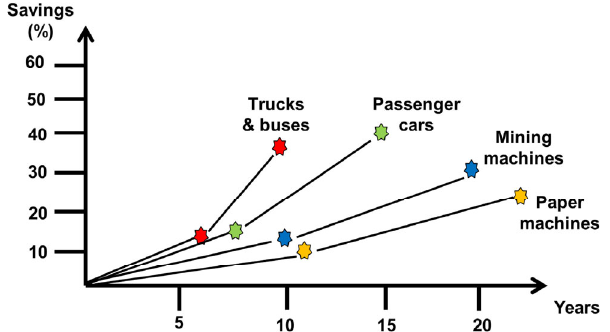
Fig. 11 Calculated potential savings over current state of the art by the introduction of advanced tribology solutions in four case studies and their time scale of